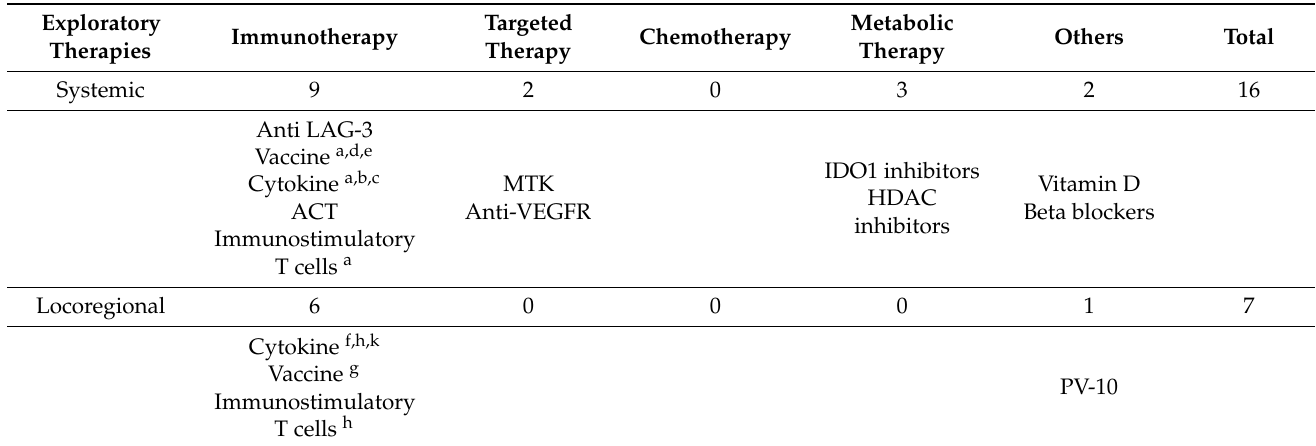
Table 2. Number and types of exploratory therapy trials per category classified by mode of